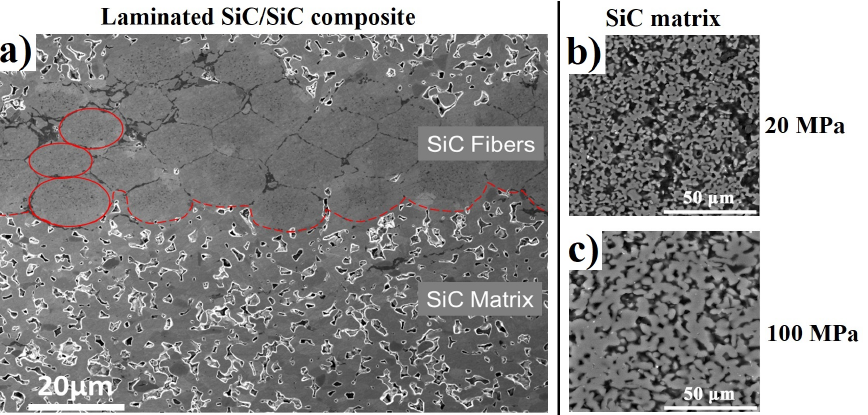
Figure 2. SEM image of SiC f /SiC composites sintered at 100 MPa ( a ), SiC matrix at 20 MPa ( b ), and 60 MPa ( c ).